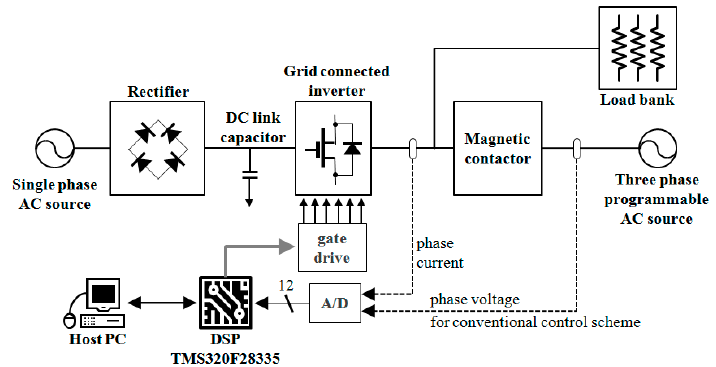
Figure 3. Configuration of the overall system.